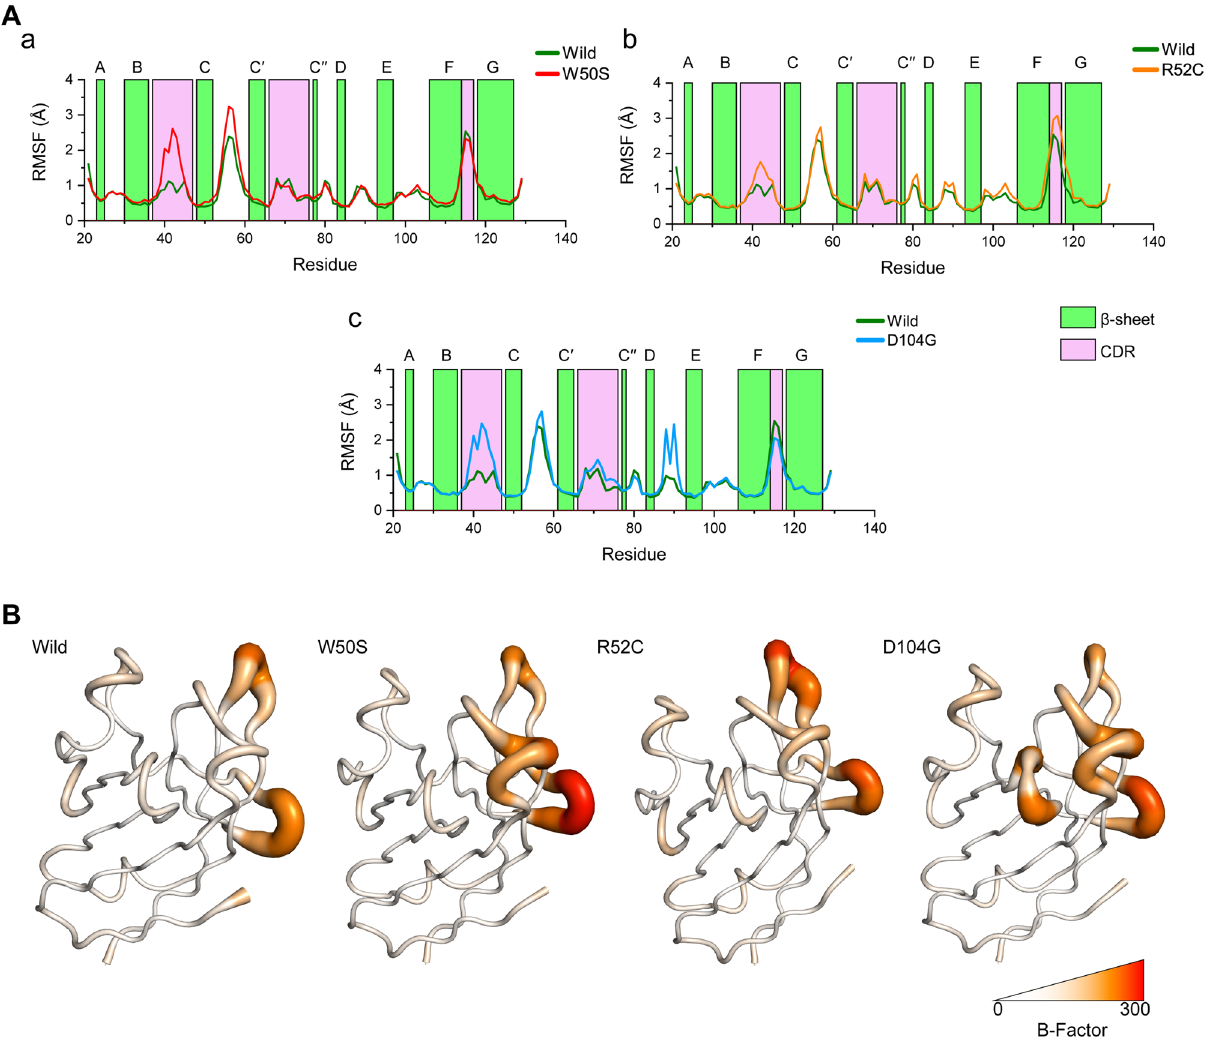
Figure 3. Changes in residual flexibilities during simulation. ( A ) Changes are represented by root mean square fluctuation (RMSF) plots for W50S ( a ), R52C ( b ), and D104G ( c ) versus the wild-type structure. Color bars represents β-sheet propensity and CDRs. ( B ) Comparison of TREM2 Ig domain fluctuations as demonstrated by B-factor coloring and thickness. RMSF values were converted to B-factors to represent structures in colored putty representations . Coloring was made by white-red spectrum, white means B-factor with a value 0, while red means 300. Tube thicknesses also indicate levels of fluctuation, i.e., tube thicknesses represent levels of